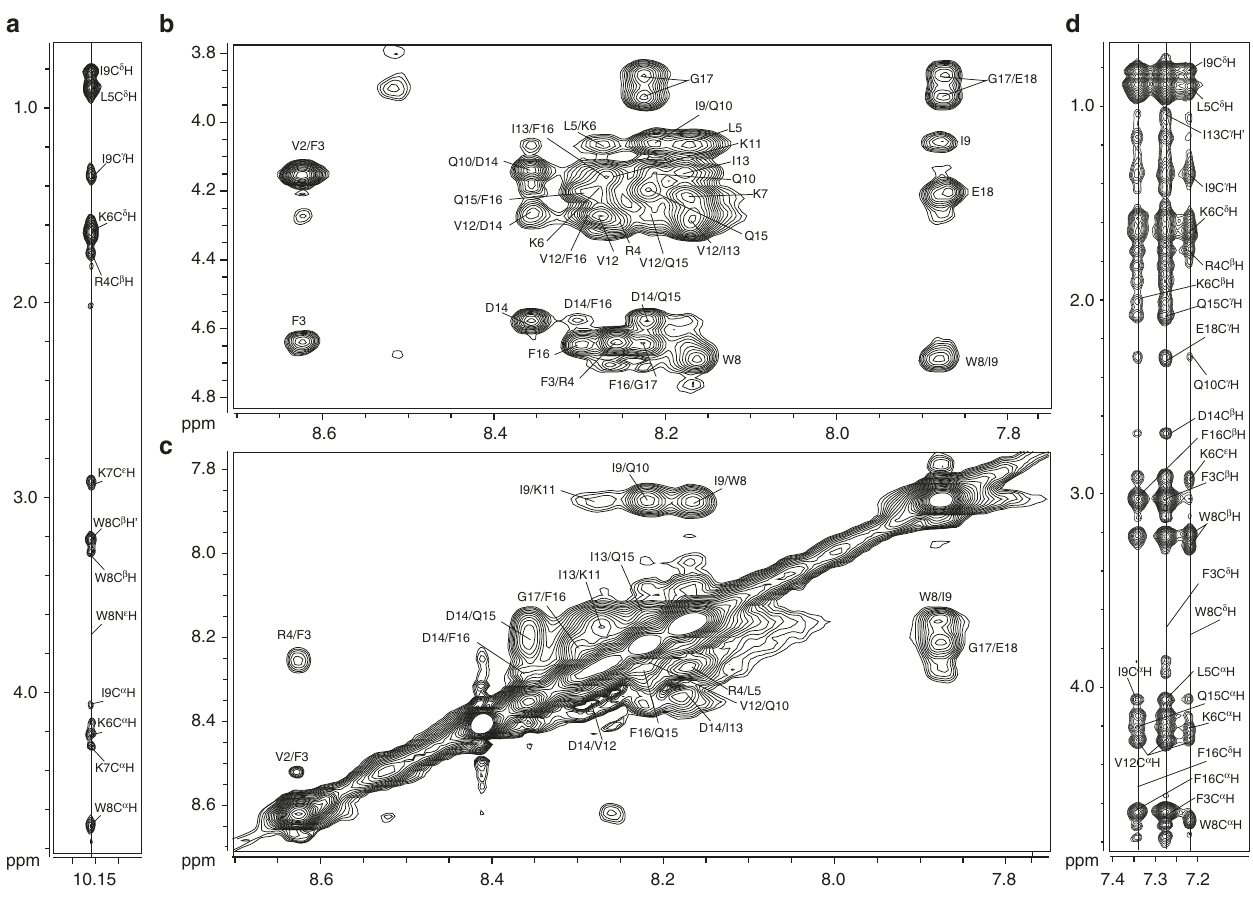
Fig. 3 tr-NOESY spectrum of HVF18 in LPS micelles. Two-dimensional 1 H – 1 H tr-NOESY spectrum of HVF18 (0.5 mM) in the presence of LPS (20 μ M) ( a ) showing NOE connectivities involving W8 indole proton with the up fi eld shifted aliphatic proton resonances. b Finger print region showing sequential and medium range NOE connectivities between backbone alpha and amide proton (C α H/HN) resonances, ( c ) section showing NOE connectivities among backbone amide (HN/HN) resonances and ( d ) section showing NOE connectivities between the aromatic ring protons of F3, F16, and W8 with the up fi eld shifted aliphatic proton resonances. tr-NOESY spectrum of HVF18 in LPS micelles was obtained in aqueous solution (pH 4.5) at 298 K in a Bruker DRX 600 MHz NMR